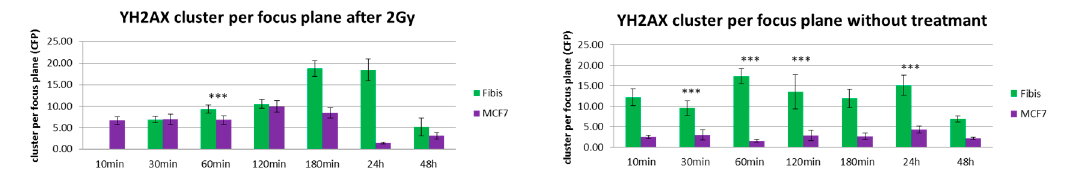
Figure 6. Number of detected γ H2AX clusters in MCF-7 breast cancer cell nuclei (“MCF-7”) in comparison to cell nuclei of CCD-1059SK fibroblasts (“Fibis”). The columns of each panel represent the mean values calculated from 20 nuclei each. The error bars on top of the column indicate the standard deviation. For each time step after the irradiation process, the data are given for cells exposed to ionizing radiation of 2 Gy ( left ) and for cells subjected to the same culturing procedure but not to radiation treatment ( right ). Level of significance between the corresponding values: *** = 0.1%. For further details see text.